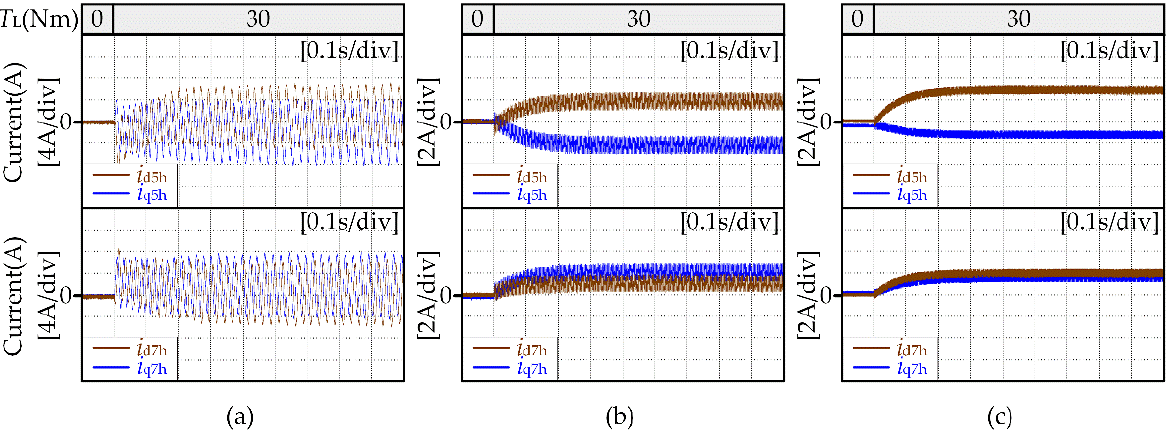
Figure 12. The 5th and 7th current harmonic components extracted by the traditional method when the load torque is 30 Nm. ( a ) 100 rpm; ( b ) 1000 rpm; and ( c ) 2500 rpm.